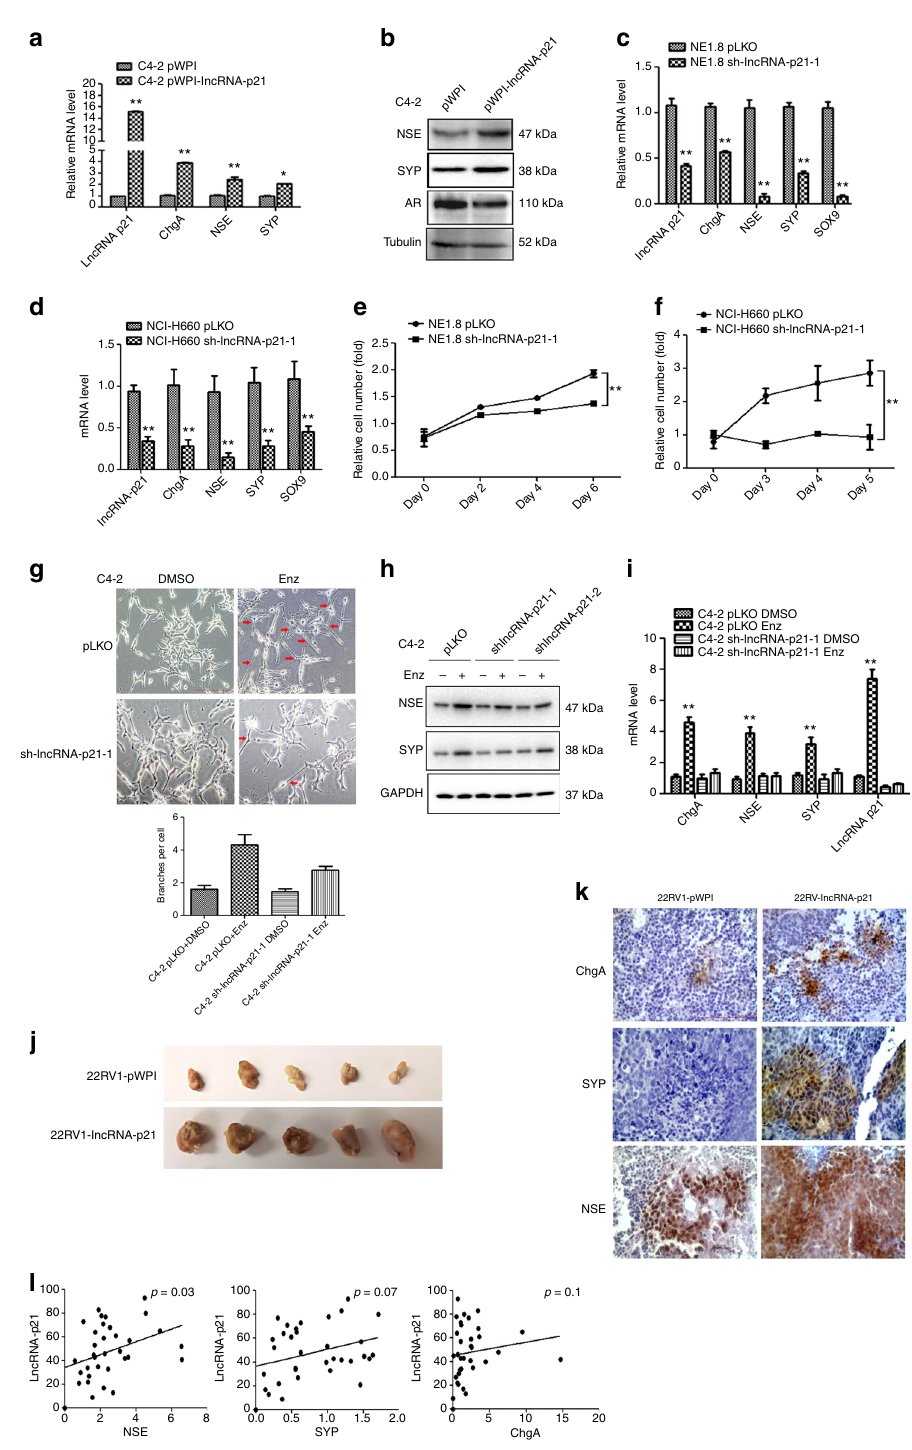
Fig. 2 The lncRNA-p21 is the key factor to promote the NED after Enz treatment and maintain the NE cell characteristics. a Overexpressing lncRNA-p21 in C4-2 cells for NE markers analysis by qPCR. b Overexpressing lncRNA-p21 in C4-2 cells for NE markers analysis by WB. c The NE markers in NE1.8 cells after knocking down lncRNA-p21 were determined by qPCR. d The NE markers in NCI-H660 cells after knocking down lncRNA-p21 were determined by qPCR. e The lncRNA-p21 was knocked down in NE1.8 cells and cell viability was analyzed by MTT. f The lncRNA-p21 was knocked down in NCI-H660 cells and cell viability was analyzed by MTT. g Cell morphology of pLKO and sh-lncRNA-p21 C4-2 cells after Enz treatment. (Scale bar = 20 μ m) h Knockdown of lncRNA-p21 decreased the Enz-induced NE marker protein levels. The C4-2 pLKO control and sh-lncRNA-p21 cells were treated with Enz for 6 days, and then the NE markers analyzed by WB. i Knockdown of lncRNA-p21 decreased the Enz-induced mRNA of NE markers. The C4-2 pLKO control and sh-lncRNA-p21 cells were treated with Enz for 6 days, and then the NE markers determined by qPCR. j Images of 22RV1-pWPI and 22RV1-lncRNA-p21 xenograft tumors. k The IHC staining of the NE markers in 22RV1-pWPI and 22RV1-lncRNA-p21 xenograft tumors. l The correlation of expressions of LncRNA-p21 and NE markers (NSE, SYP, ChgA) in human prostate cancer samples. ( n = 34). For c – f , i , l , the data are presented as mean ± SD, ** p < 0.005. by t- test for two groups or ANOVA for more than two groups NATURE COMMUNICATIONS| (2019) 10:2571